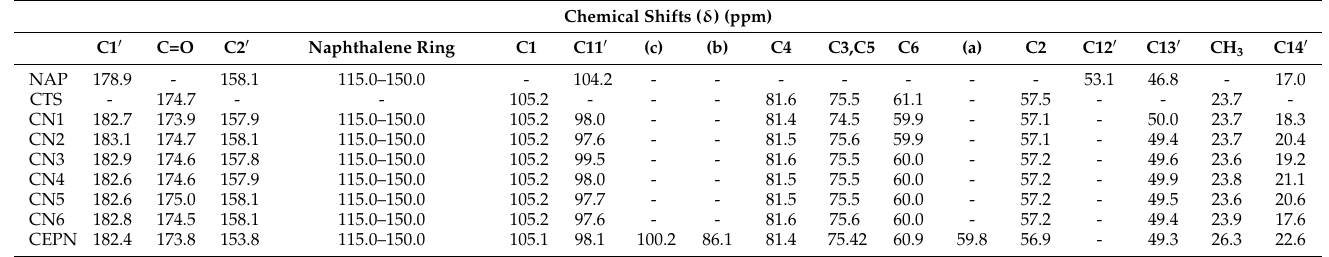
Table 2. Assignment of the chemical shift of the 13 C NMR spectra of NAP, CTS, CN and CEPN salts.